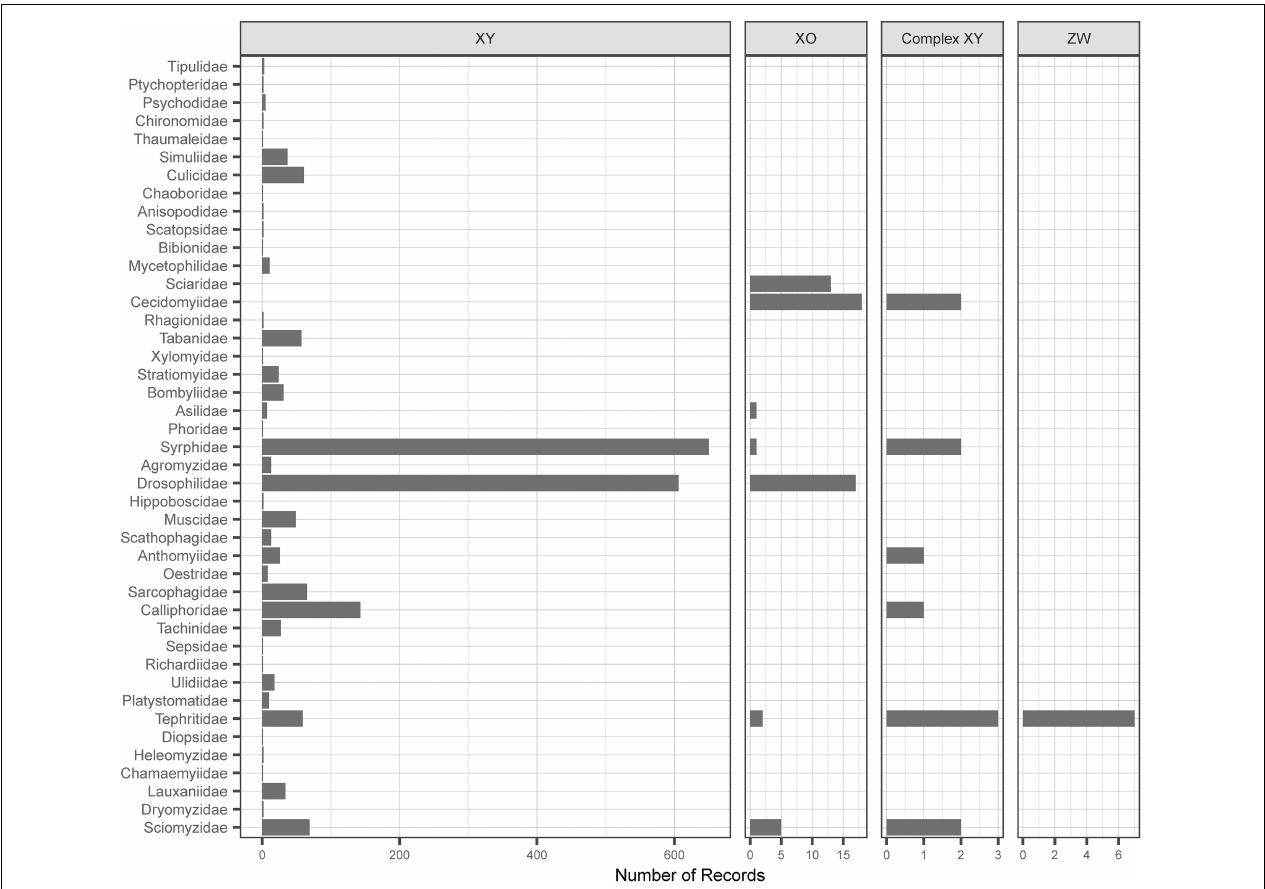
FIGURE 2 | Distribution of sex chromosome systems across families of Diptera. The order of families is the same as in Figure 1 . Note scales on horizontal axis vary in size to allow visualization of rare sex chromosome